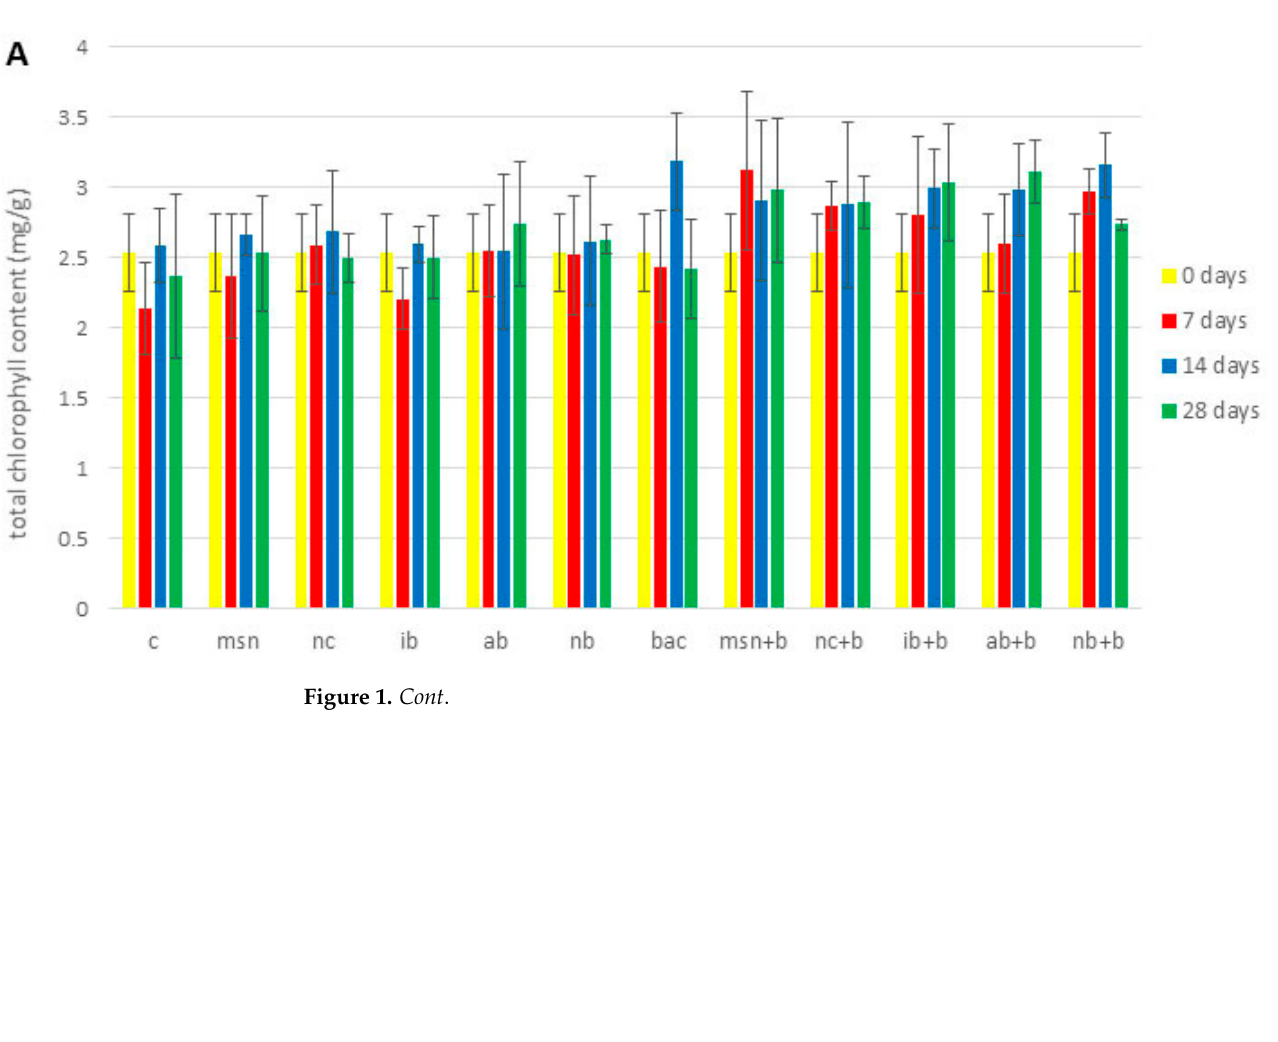
Figure 1. Total chlorophyll content (mg/g fresh mass). ( A ) 2nd tomato experiment; ( B ) watermelon experiment. Abbreviations: C—control; MSN—chitosan-coated mesoporous silica nanoparticles; NC—nanoclay; IB—“Italian” biochar; AB—Aries Green biochar; NB—Naked biochar; B—bacteria; MSN + B—chitosan-coated mesoporous silica nanoparticles with adsorbed bacteria; NC + B— nanoclay with adsorbed bacteria; IB + B—“Italian” biochar with adsorbed bacteria; AB + B—Aries Green biochar with adsorbed bacteria; NB + B—Naked biochar with adsorbed bacteria. Differences in chlorophyll content between control and treated plants were statisti- cally significant at the end of both the 2nd tomato and the watermelon experiment (Figure 1). In the 2nd tomato experiment the chlorophyll content in treated plants increased 1.1– 1.3 times (compared to control) after 28 days. After 30 days, chlorophyll content in treated plants increased 1.1–1.4 times compared to control. Interestingly, differences were evident only at the end of the experiments, which agrees with Hou et al. [78] who reported that